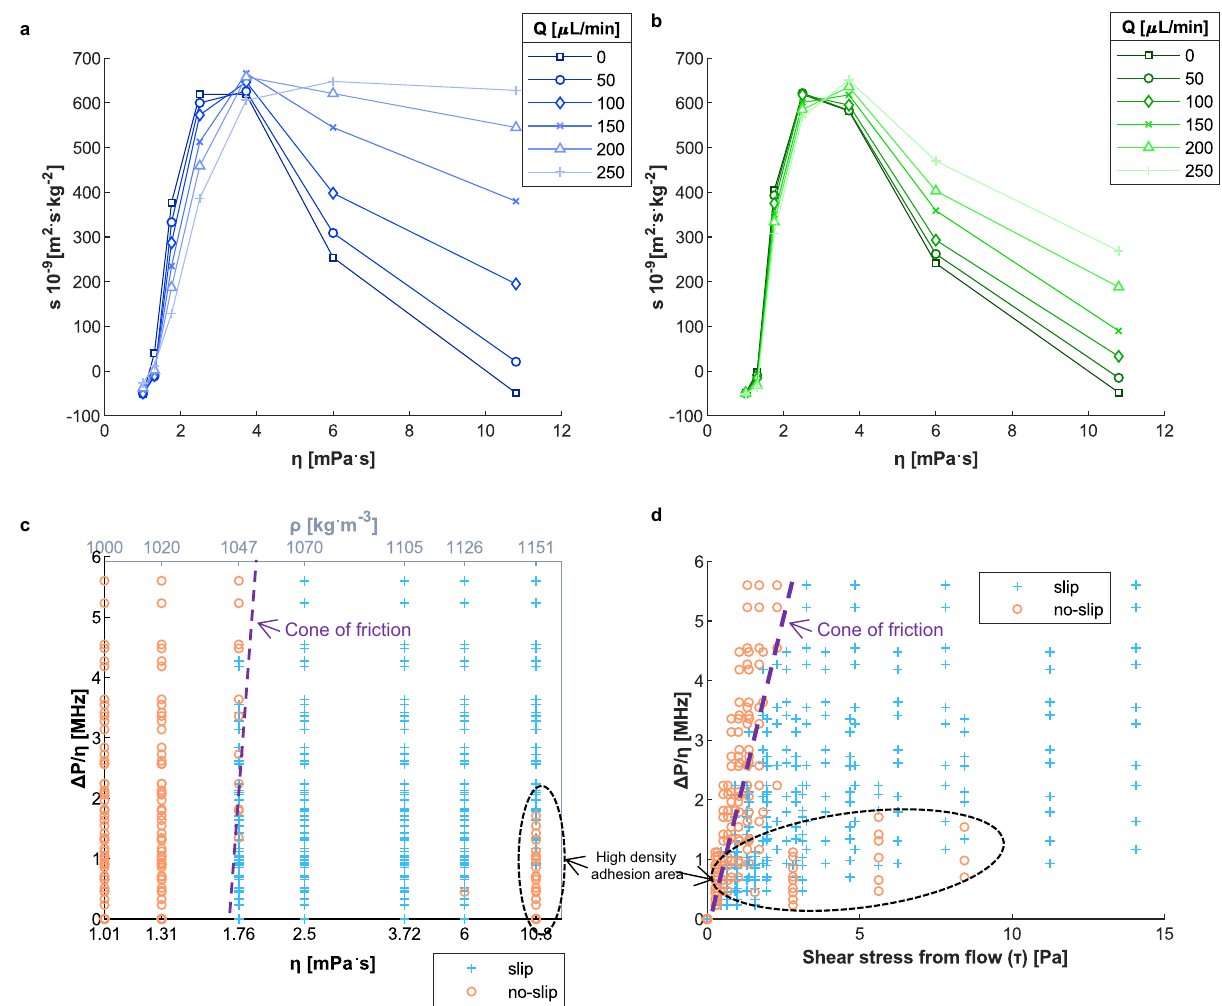
Fig. 3 Coupling between pressure and shear stress for acousto- fl uidic slip. a, b Slip coef fi cient s of M 1 for different fl ow rates, Q , in the direction D 1 ( a ) and D 2 ( b ) as a function of the fl uid viscosity, η . The amplitude of s depends on the fl ow direction. Therefore, the slip depends on the pressure. c , d Shear stress and pressure conditions generating acousto- fl uidic slip using all sensors M 1 to M 5 . c Focus on the acoustic shear stress. Most of the no-slip conditions with regard to fl ow pressure and acoustic shear are concentrated in a cone that is analogous to the friction cone. This friction cone separates the area where the fl uid pressure exceeds the acoustic shear stress (no-slip red circle markers), and the area where the acoustic shear stress surpasses the fl uid pressure (slip blue plus sign markers). A second adhesion area (black oval) at η = 10.8 mPa . s indicates that the pressure due to the fl uid mass surpasses the acoustic shear stress. d Focus on the fl ow shear stress. The friction cone separates the fl ow pressure-shear conditions generating adhesion (orange circles) from the conditions generating slip (blue plus sign). The pressure related to the fl uid mass is compensated by the increase in shear stress from fl ow, switching from an adhesion regime at high viscosity (black circle) to a slip regime. The shear stress transition threshold is ≈ 10